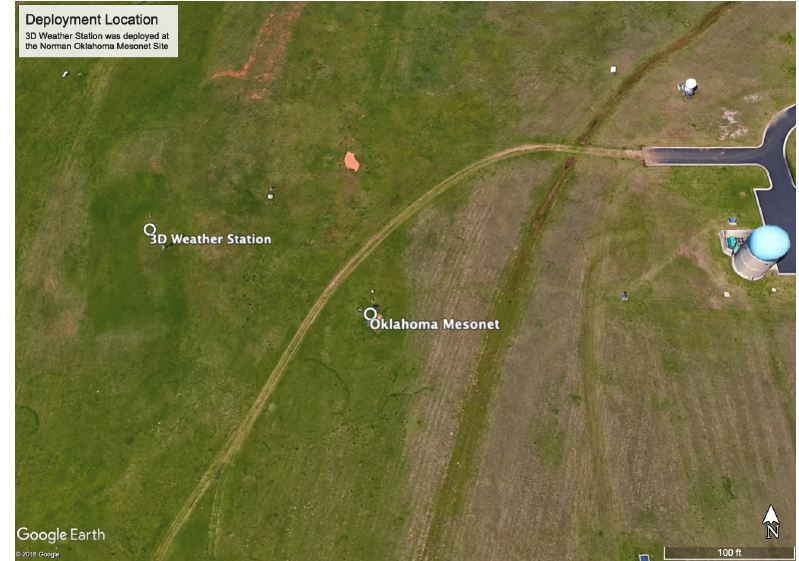
Figure 3. Location of the 3D-printed weather station relative to the Oklahoma Mesonet. Image courtesy of © Google Earth.